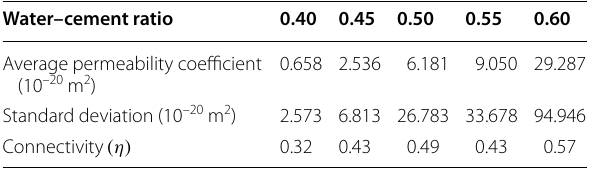
Table 1 Model simulation result for different water–cement ratios.